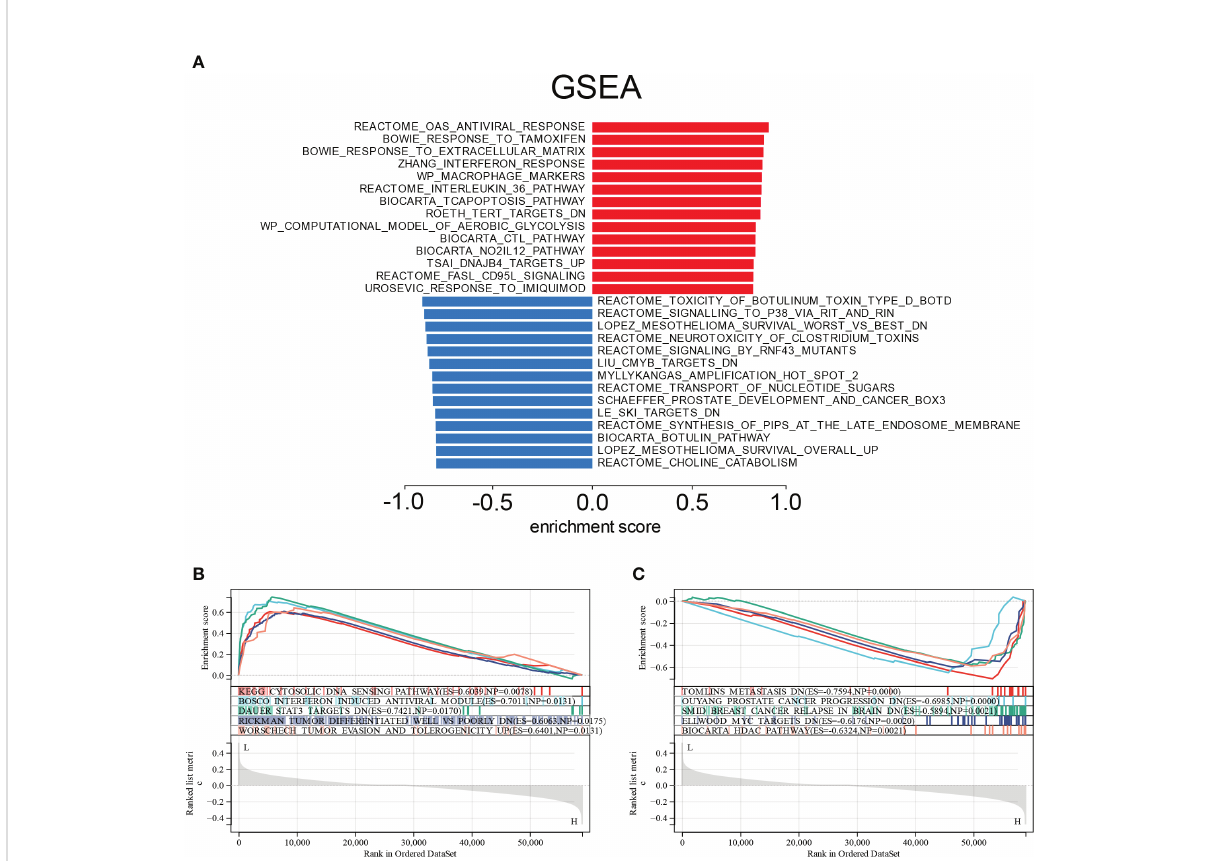
FIGURE 6 Enrichment plots from GSEA. (A) Signi fi cantly enriched pathway annotations of CESC. (B) Signi fi cantly positive enriched pathways in low E6ratio CESC patients. (C) Signi fi cantly positive enriched pathways in high E6ratio CESC